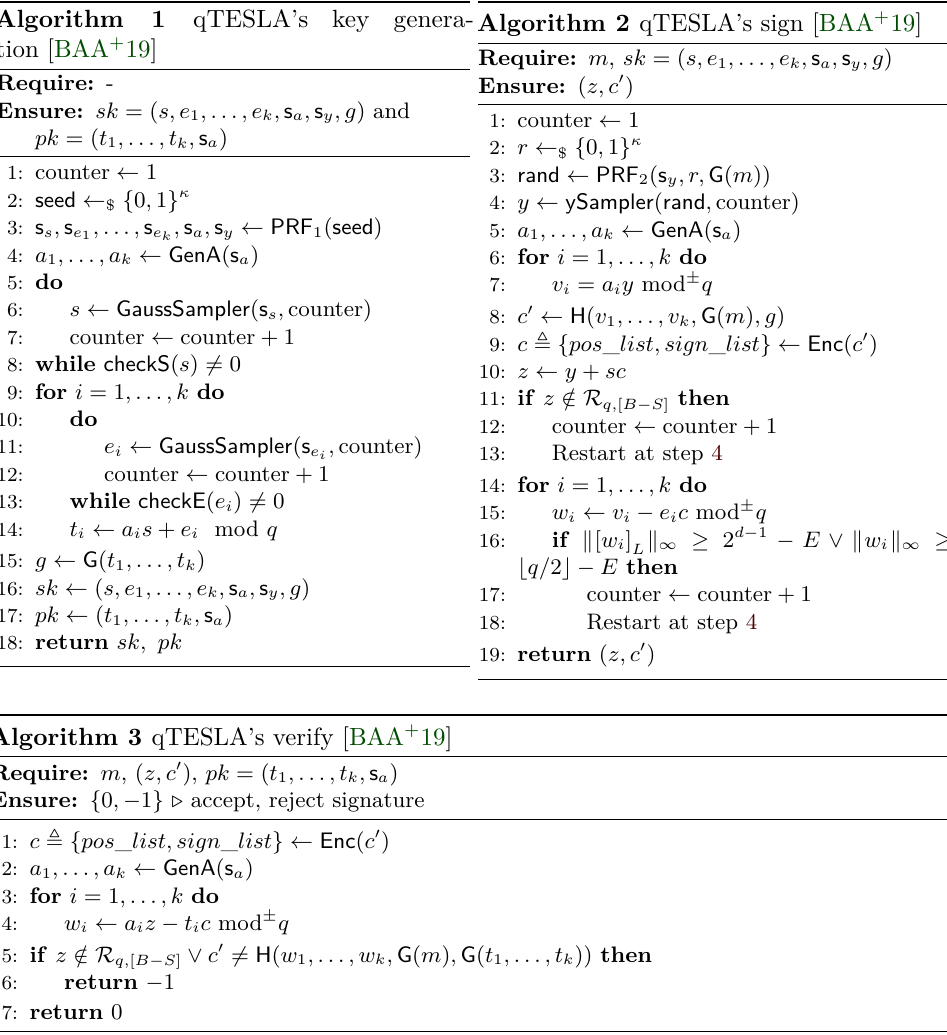
Algorithm 1 qTESLA’s key genera- Algorithm 2 qTESLA’s sign [BAA + 19]